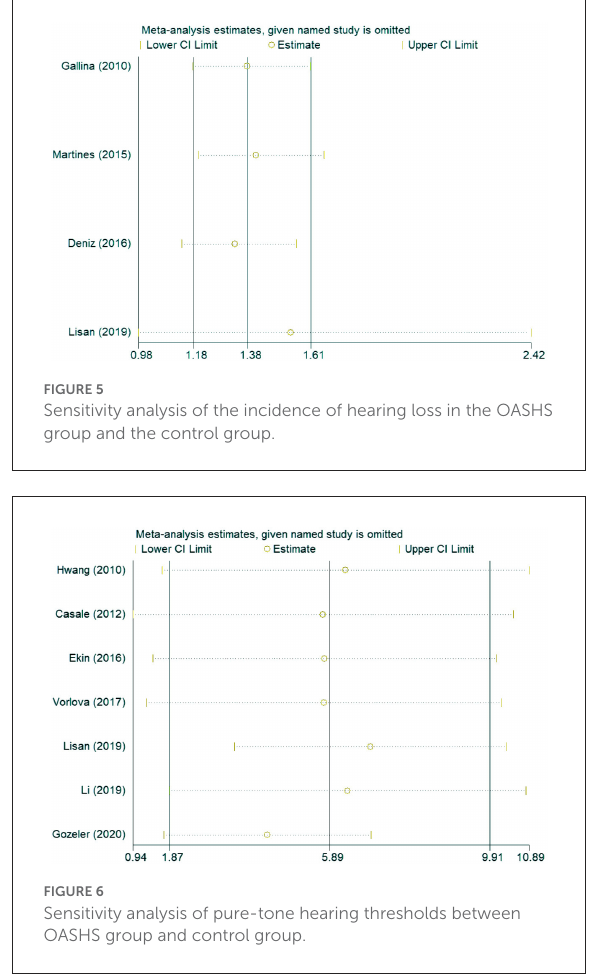
FIGURE6 Sensitivity analysis of pure-tone hearing thresholds between OASHS group and control group.